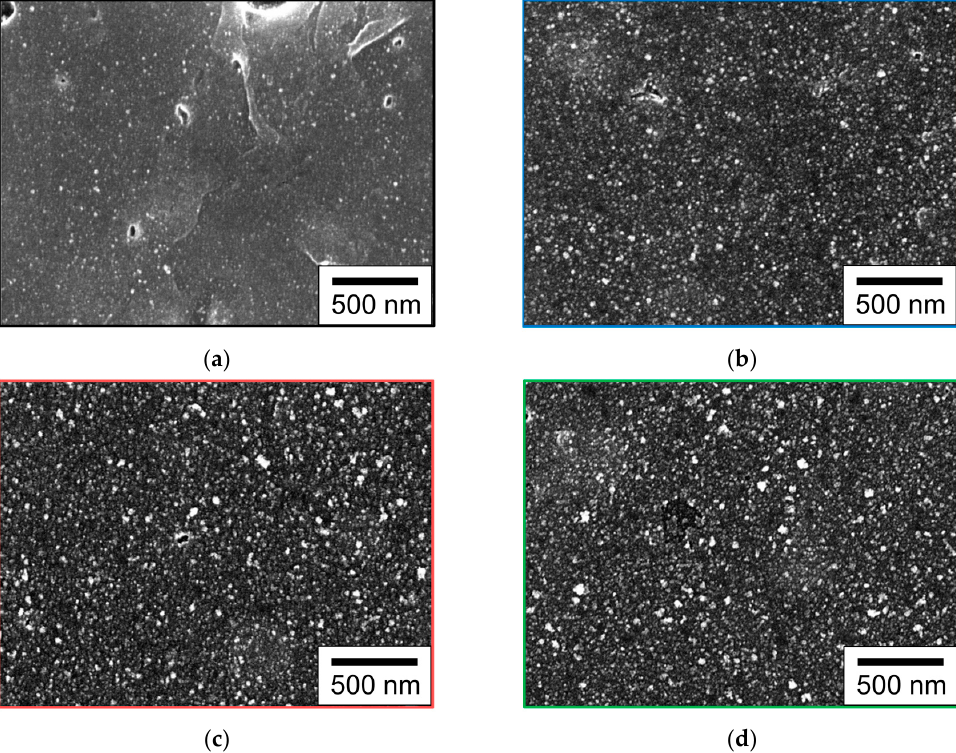
Figure 4. Scanning electron microscope (SEM) images of the surface of an ABS substrate before and after PDA coating and Pt immobilization: ( a ) Pt / ABS-untreated, ( b ) Pt / ABS-PDA(1h), ( c ) Pt / ABS-PDA(3h), and ( d ) Pt /